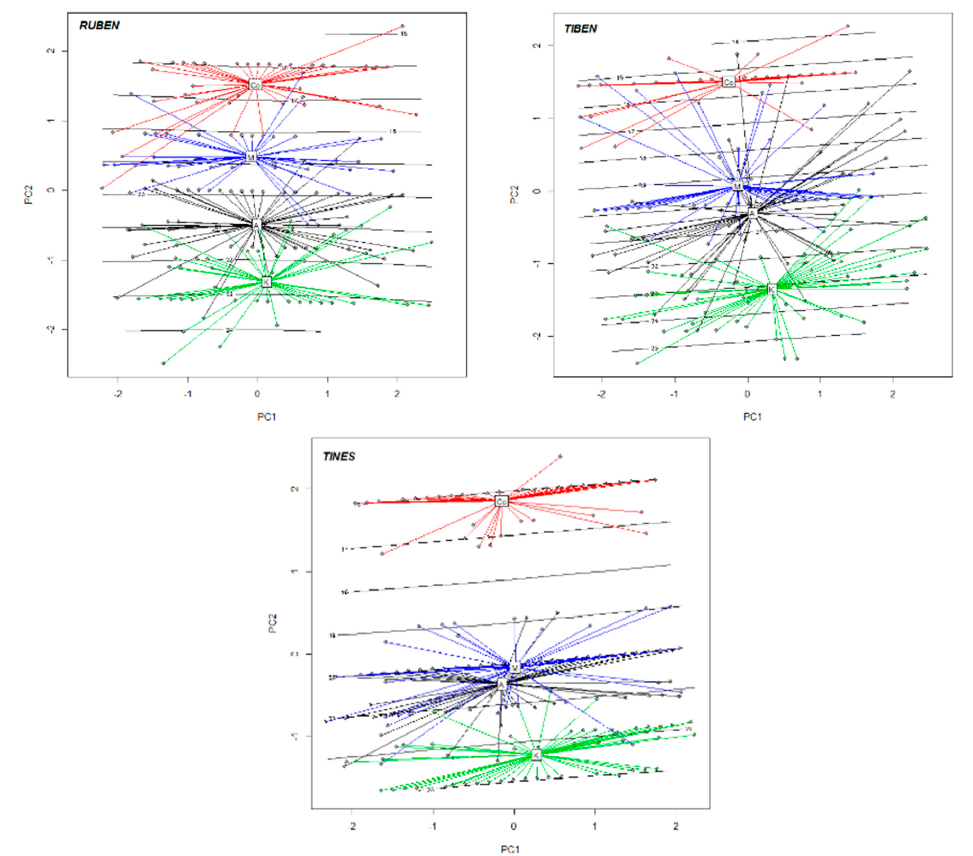
Figure 1. Growth dynamics of varieties due to fertilizers projected to the final growth (d98). Co—control, A—Ascovigor, M—Mikromix, K—Kombimax. A full description of treatment recipes is provided in Table 1. Table6. ModellingofRubenvarietyfinalgrowth(d98)basedondevelopmentstageandappliednutrient.